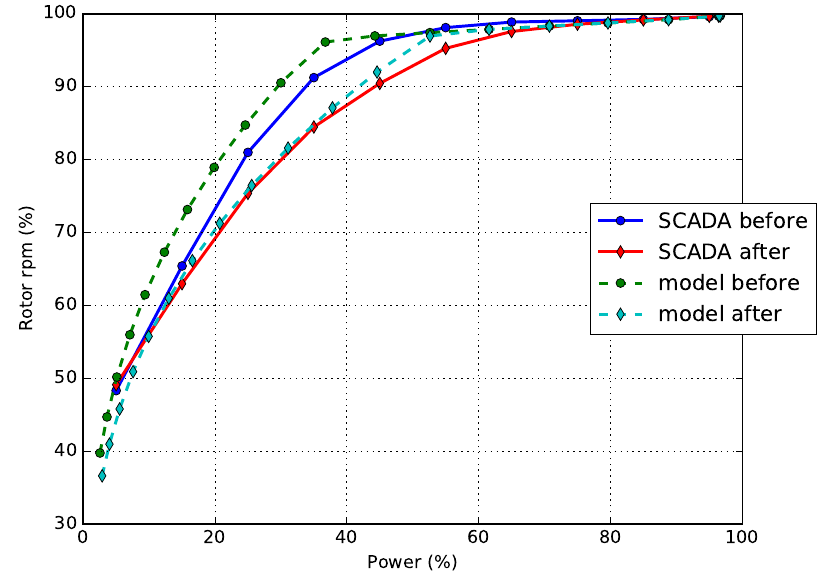
Figure 6. Pre- and post-upgrade simulated and measured rotor rpm–power curves.